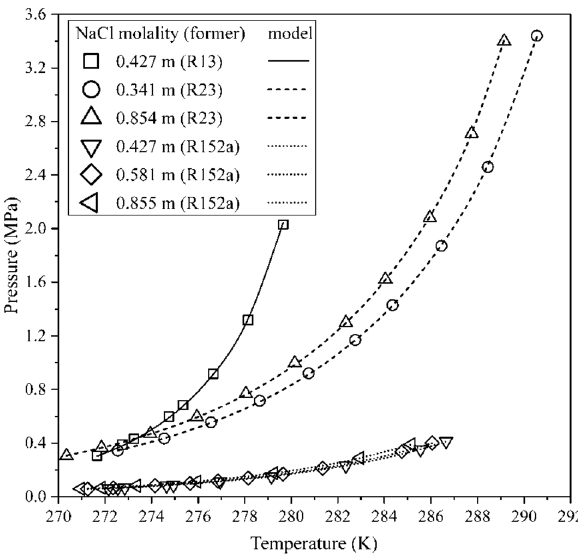
Figure 3. Experimental and estimated hydrate phase equilibrium conditions for hydrates of R13 40 , R23 40 and R152a 40 in presence of NaCl. The equilibrium conditions of R152a hydrates are marginally affected by varying concentrations of NaCl when compared to the other hydrate